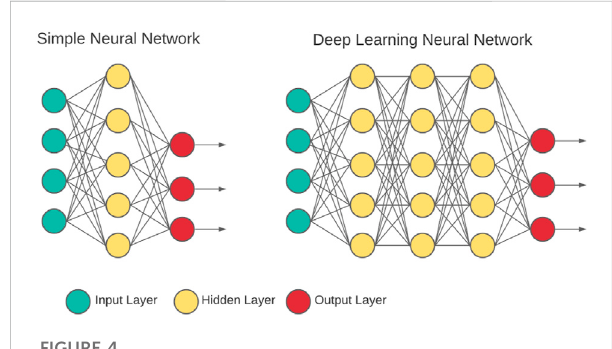
FIGURE 4 Deep learning neural network (Bhardwaj et al., 2018).